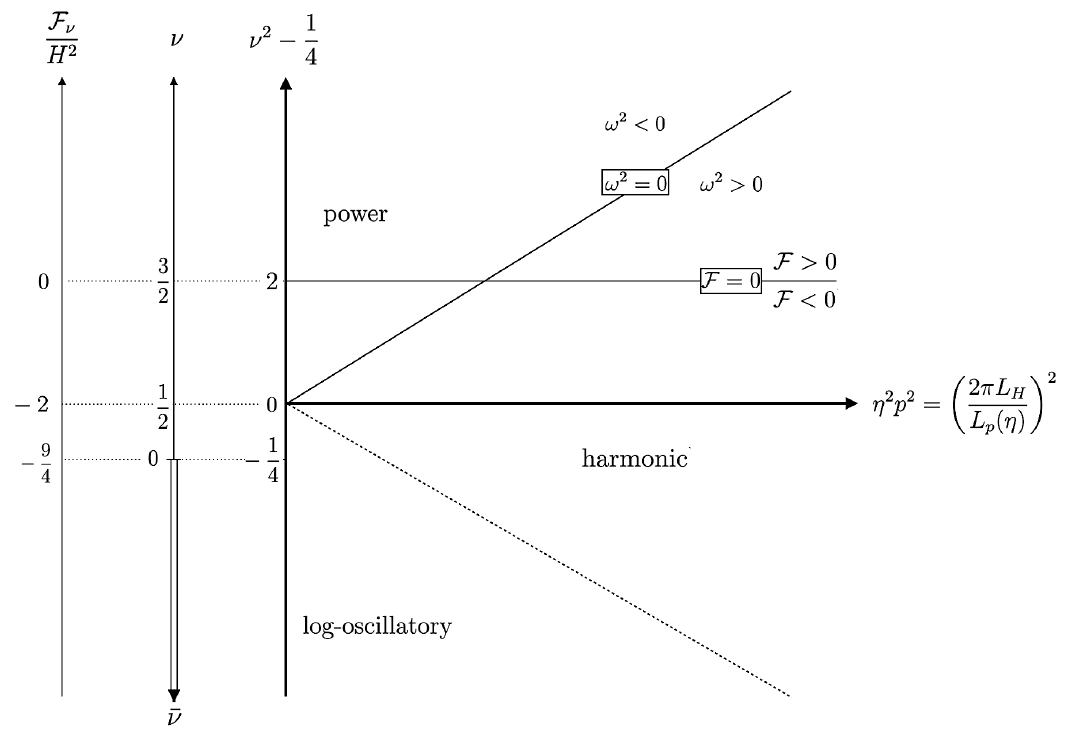
Figure 3. The ν - p plane of the eigenfunctions χ ν, p . The vertical axis corresponds to the spectrum of the d’Alembertian. It is labeled in three different ways, each convenient in its own right. The horizontal axis represents the square of the degeneracy index p (multiplied by η 2 ). The two diagonals separate the power-, harmonic-, and logarithmic oscillation regimes, respectively. The horizontal line at ν = 3 / 2 separates spacelike from timelike